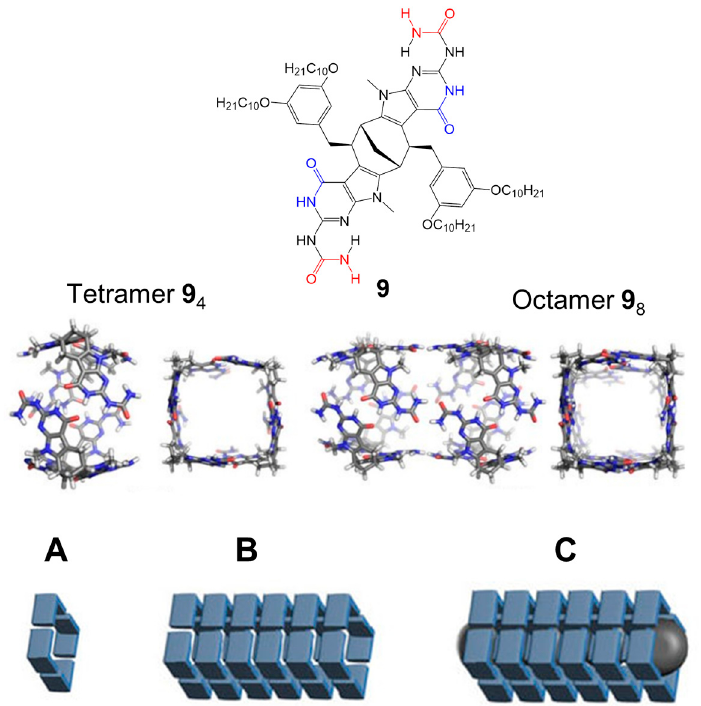
Figure 8. Monomer 9 with two orthogonal 2H-bonding sites (marked as red and blue). Molecular models of 2H-bonded tetramer 9 4 and the corresponding polymeric tube, represented as 9 8 . Schematic representation of: ( A ) tetrameric cyclic aggregate in CDCl 3 ; ( B ) nanotubular structure in toluene- d 8 ; and ( C ) nanotubular structure in CDCl 3 with C 70 as guest. Partially reproduced with permission from Ref. [48] (Copyright Nature Publishing Group, 2017).